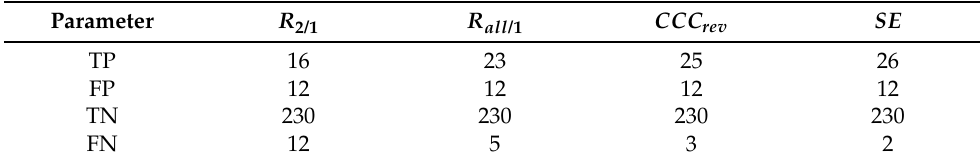
Table 4. Parameters of confusion matrices for hypothesis 2